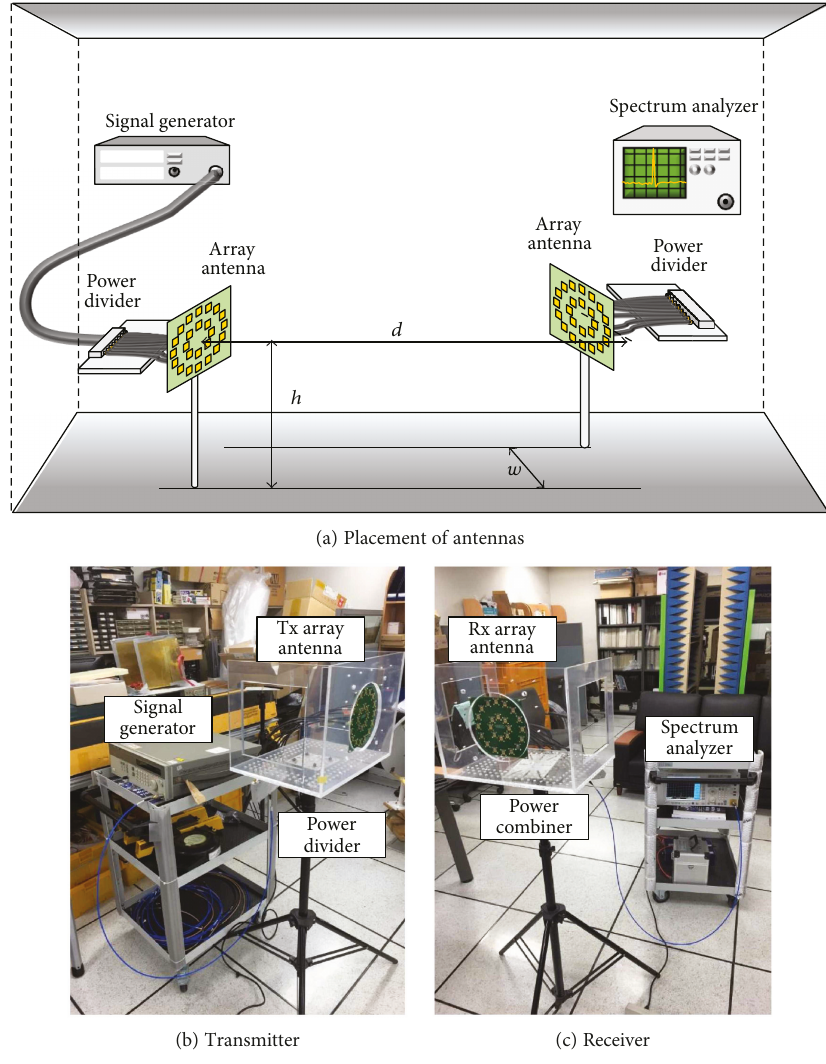
Figure 2: Experimental setup of the propagation of OAM